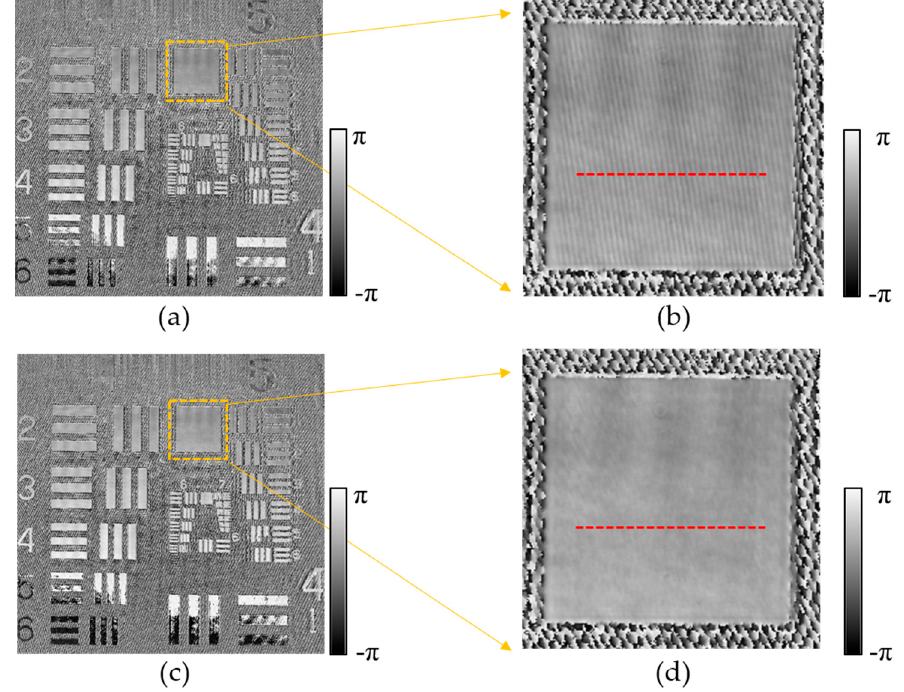
Figure 9. Experimental results of the phase images. ( a , c ) Phase images reconstructed by the conventional method and the proposed method, respectively; ( b , d ) Magnified images of the areas indicated in ( a , c ), respectively.